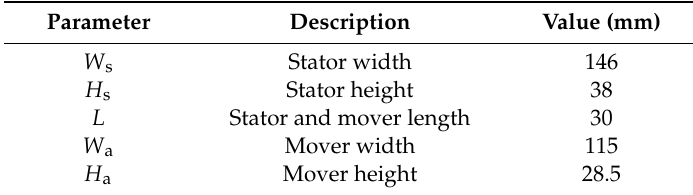
Table 1. The calculated geometrical parameters of the final actuator geometry used for prototyping and experimental